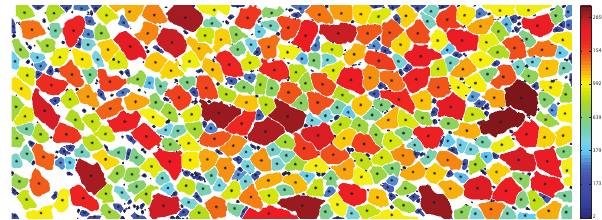
Figure 9: Floe and brash ice size distribution for Figure 7.